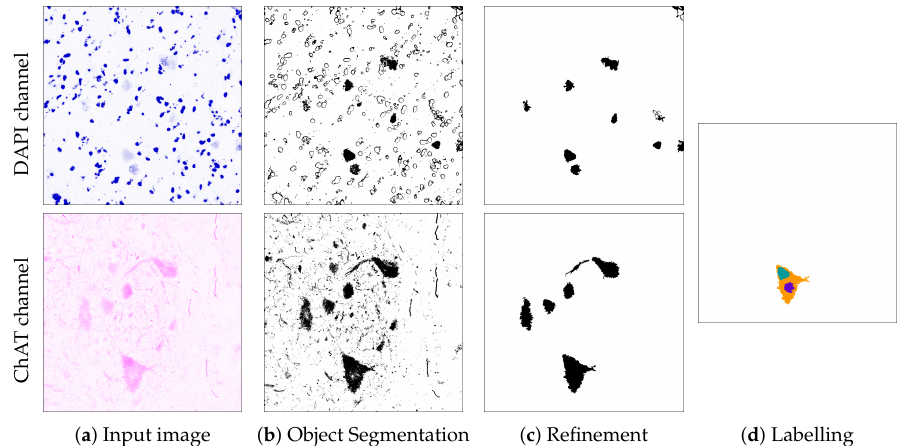
Figure 5. Visualisation of the output of each of the phases of MagNoLia for Image 1TG1B1. The segmentation is restricted to two channels, the DAPI and ChAT. Column ( a ) represents the original DAPI (coloured in blue) and ChAT (coloured in magenta) inputs; Columns ( b – d ) display the output of the object segmentation, refinement and labelling phases,